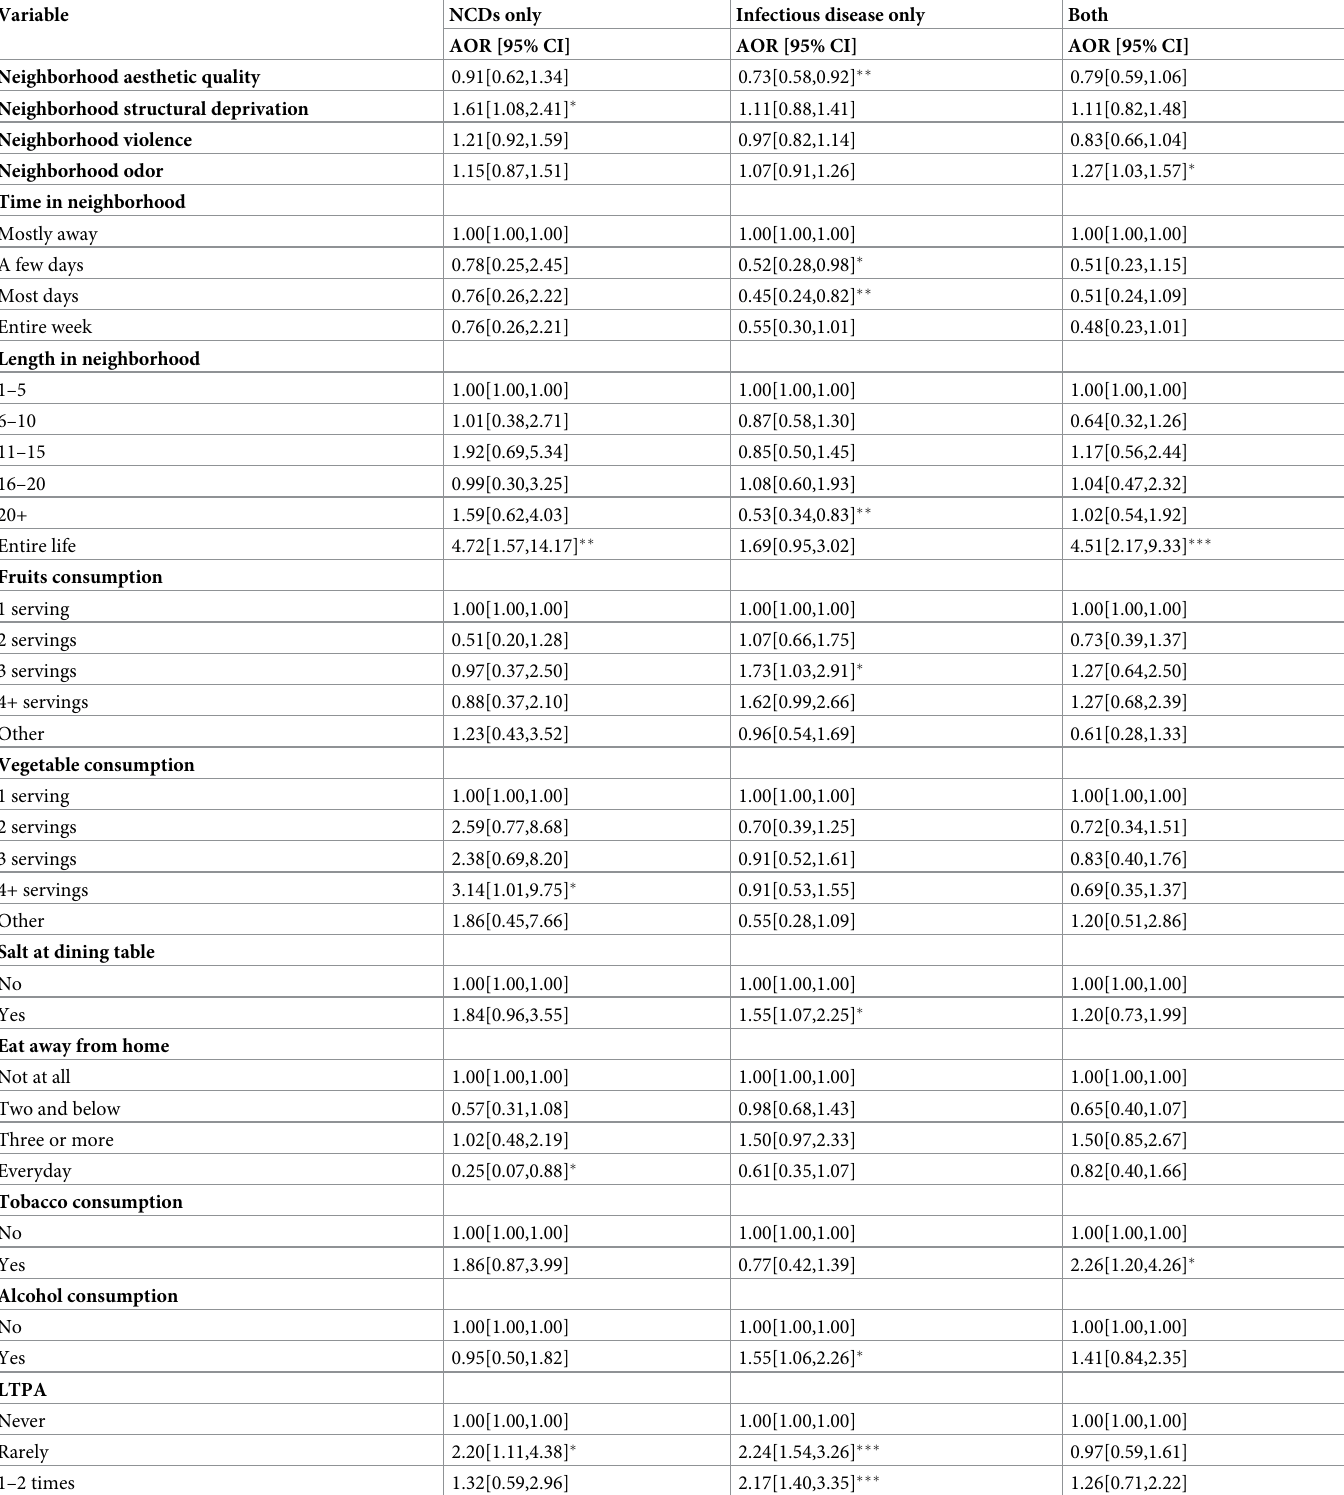
Table 3. Multinomial multilevel multivariate analysis of the relationship between chronic and/or infectious disease status and theoretically relevant